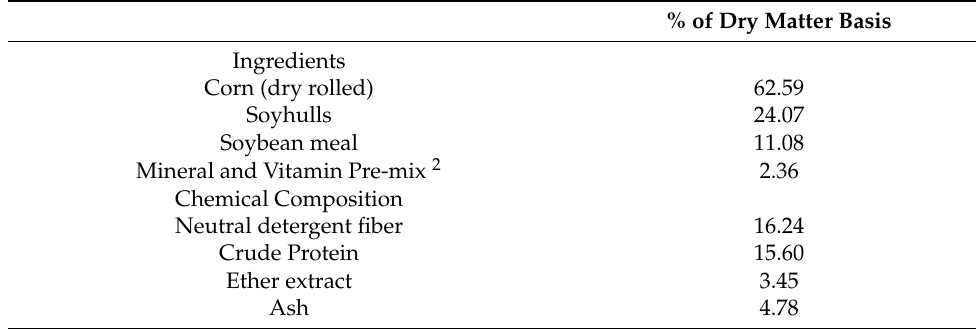
Table 3. Diet formulation and nutrient composition (expressed as % of DM basis) fed to the offspring of the pregnant ewes supplemented during late gestation (last 50 days) with no additional fatty acid or 1.01% of ca salts containing MUFA (PDS 1 ) or PUFA (EDS 1